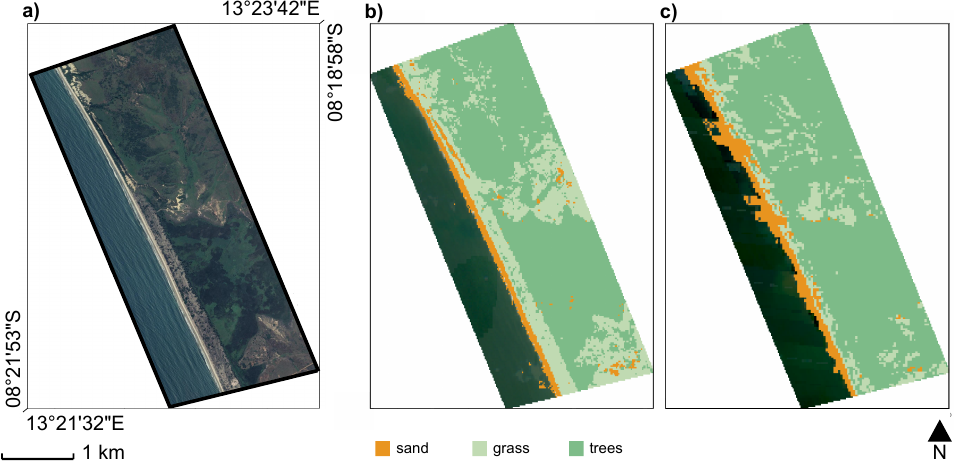
Figure 7. Comparison between ( a ) the very high-resolution satellite images for a selected AoI from Google Maps and the classification based on Sentinel-2 ( b ) and Landsat ( c ) images (EPSG: 4326). The comparison clearly highlights the higher accuracy of the Sentinel-2-derived